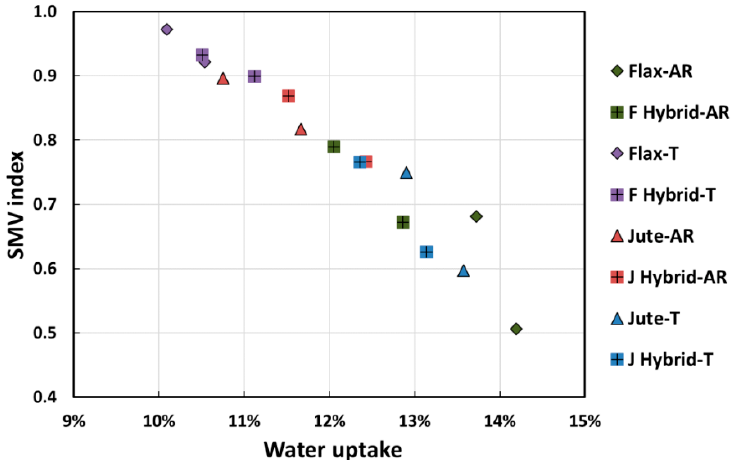
Figure 8. Relationship between moisture content and the variation of storage modulus E’ measured room at room temperature.